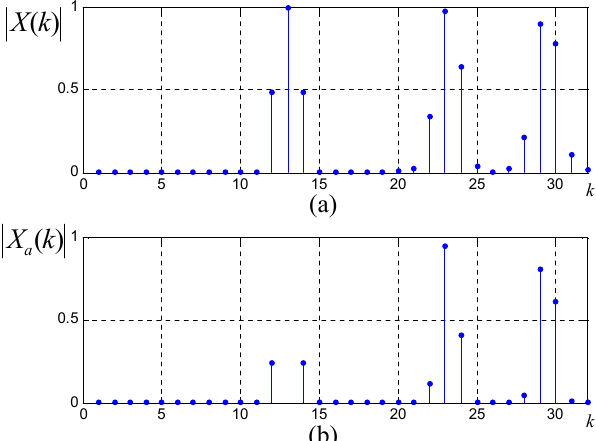
Figure 1. ( a ) Traditional 64-point DFT amplitude spectrum; ( b ) All-phase 64-point DFT amplitude spectrum.